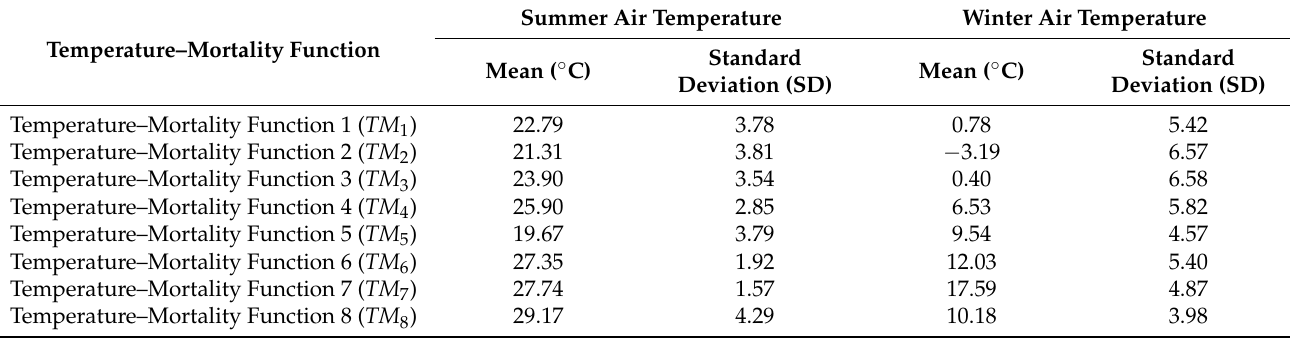
Table 1. Temperature–Mortality Functions by Corresponding Mean Summer and Winter Air